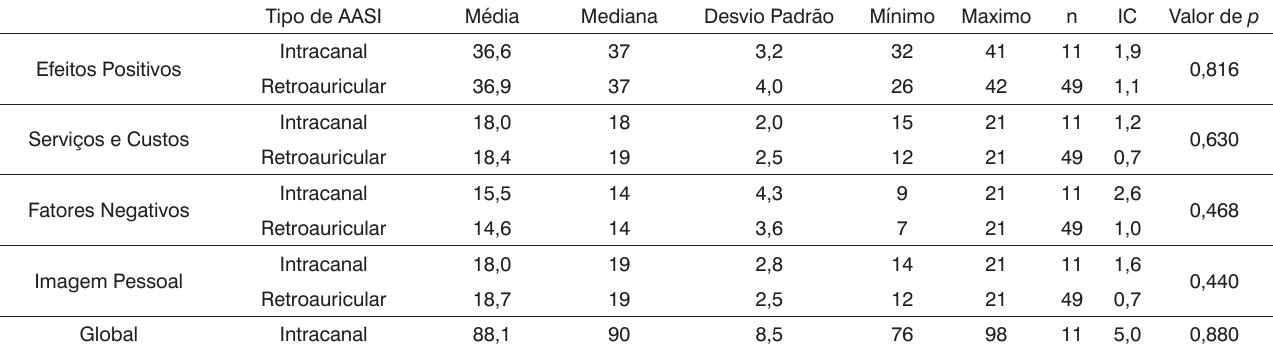
Tabela 4. Comparação da satisfação global e por subescala de acordo com o tipo de AASI em pacientes protetizados na Clínica Lumiar e avaliados entre setembro e outubro de 2011.